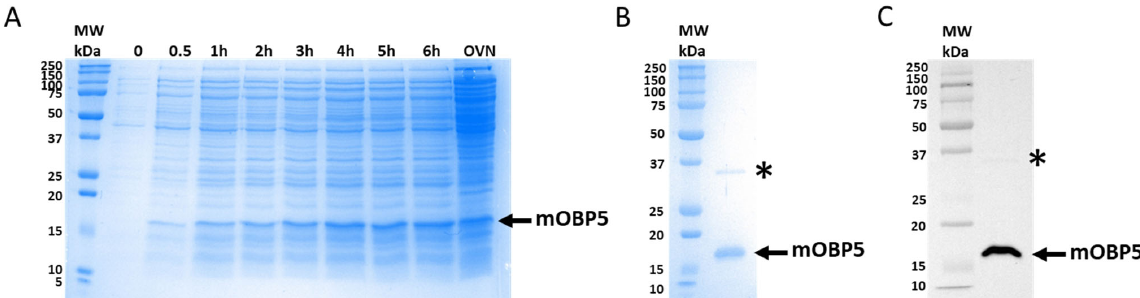
Figure 1. Electrophoretic analysis of mOBP5 expressed in bacteria. ( A ) E. coli M15 [pREP4] strain containing the pQE31 ‐ mOBP5 vector before and after IPTG induction for 30 min, 1 h, 2 h, 3 h, 4 h, 5 h, 6 h, and overnight (OVN). The position of mOBP5 is shown with an arrow. ( B ) SDS ‒ PAGE of purified mOBP5 using immobilized metal ‐ affinity chromatography. The proteins were analyzed using 12% SDS ‒ PAGE and detected using Coomassie blue staining. The molecular weight markers (kDa) are shown. The asterisk indicates a band probably corresponding to an SDS ‐ resistant dimer of mOBP5, as demonstrated with Western blot analysis. ( C ) Western blot analysis of mOBP5. The purified protein from the gel filtration was separated using SDS–PAGE followed by Western blotting using mouse anti ‐ HIS primary antibody and goat anti ‐ mouse horseradish peroxidase conjugated secondary antibody. The arrow indicates the position of purified mOBP5. The asterisk indicates a band probably corresponding to an SDS ‐ resistant dimer of mOBP5.